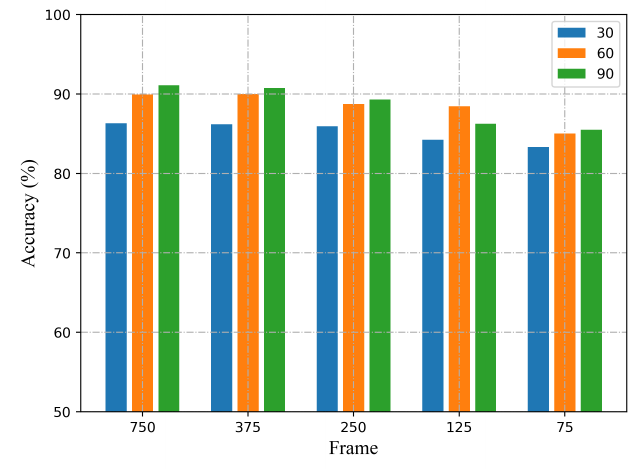
Figure 15. The recognition accuracy with different number of subcarriers and sampling